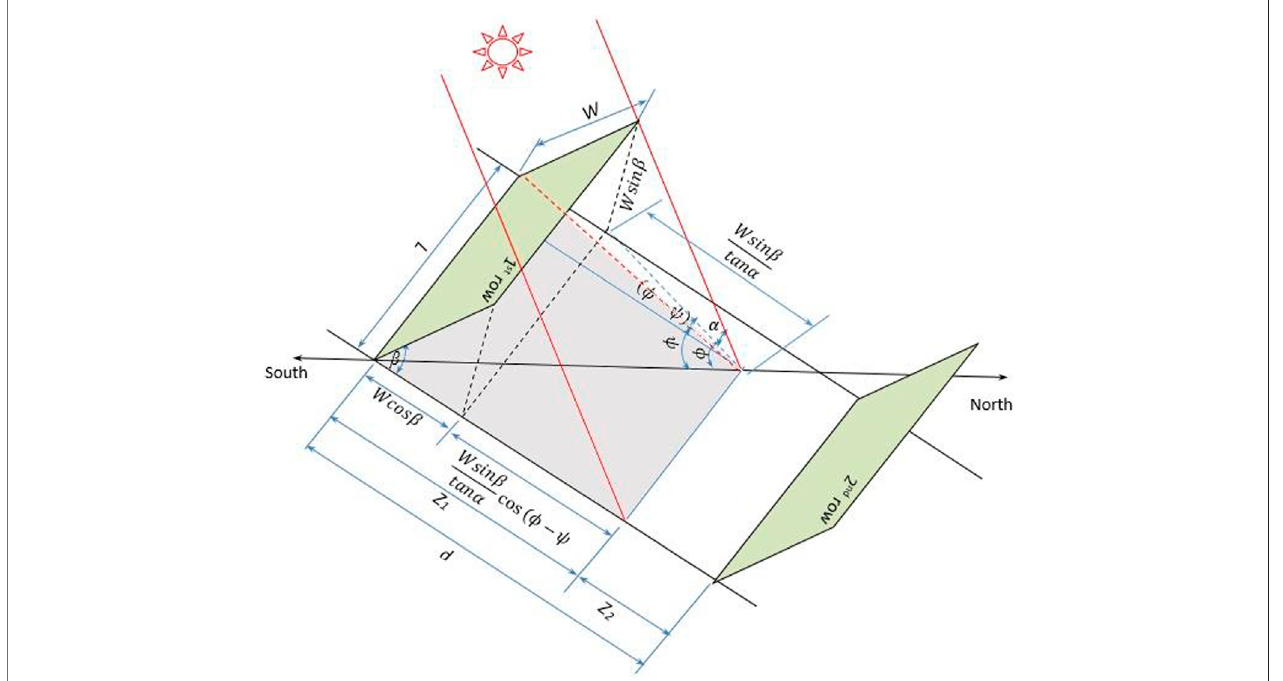
FIGURE 3 | Graphical representation of the shaded and unshaded zones in a solar fi